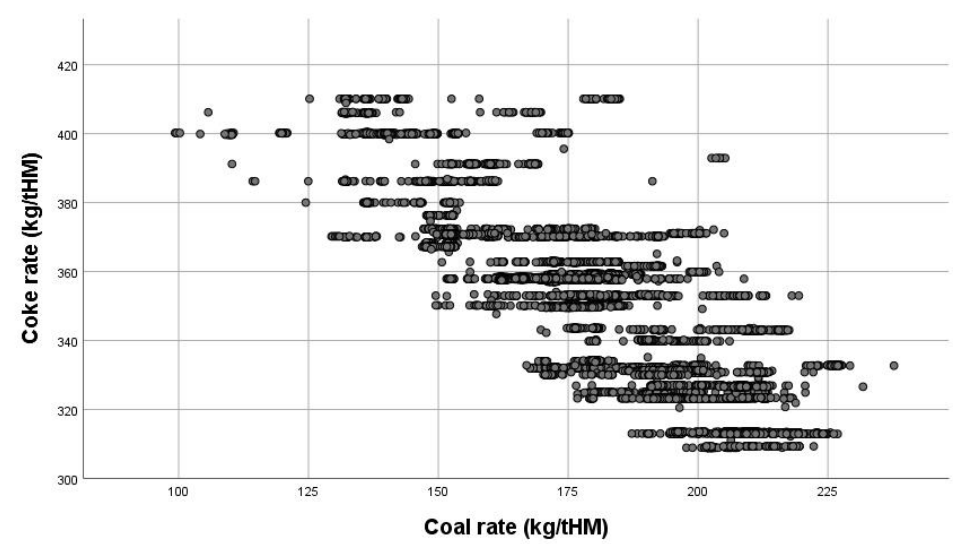
Figure 7. Scatter plot of the relationship between the injectant coal and the coke rate during blast furnace production.